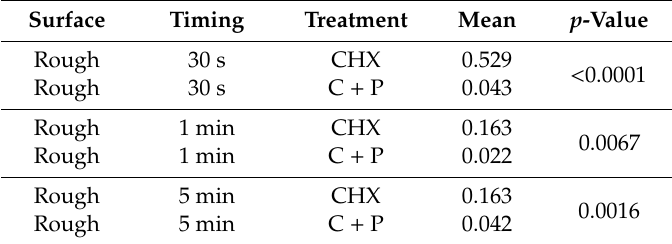
Table 3. Comparative table for rough surfaces.